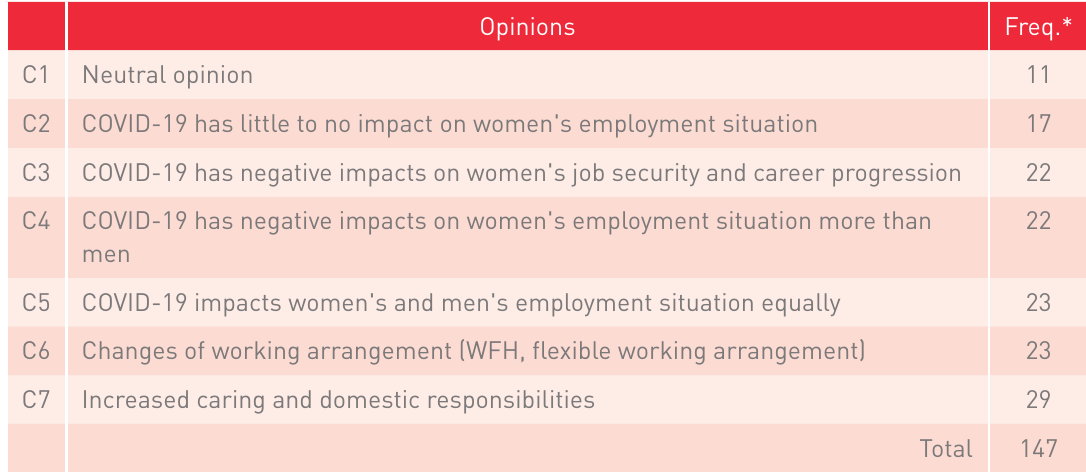
Table 5. The respondents’ opinions on women’s employment situation during the